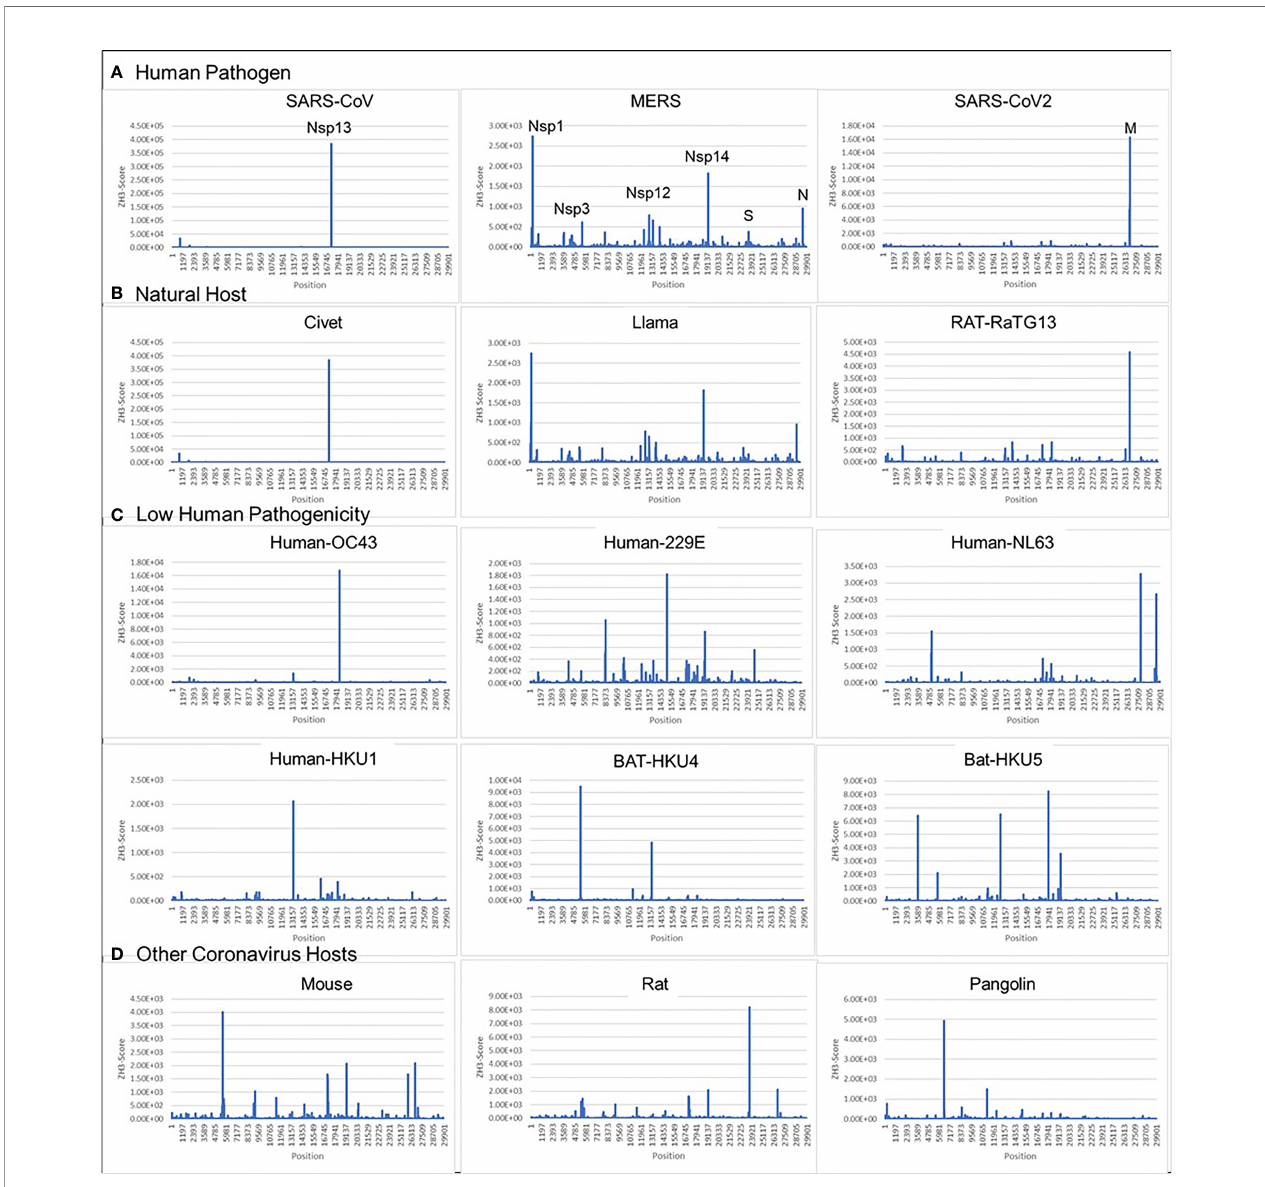
FIGURE 2 | Coronavirus signatures (Z-sigs) based on Z- fl ipons (A) Z-sigs for each human pathogenic virus are unique. (B) Z-sigs match those for the presumed natural hosts for each virus. (C) The Z-Sigs differ from those for other known coronaviruses (D) The Z-sigs also vary with the host animal infected. The Z-sig was derived using the ZHUNT3 (ZH3) program (15) that scores the propensity of sequences to fl ip to the left-handed helical Z-conformation. Sequences with a score greater than 600 are likely to adopt the Z-conformation under physiological conditions. Sequences were aligned using MAFFT prior to analysis